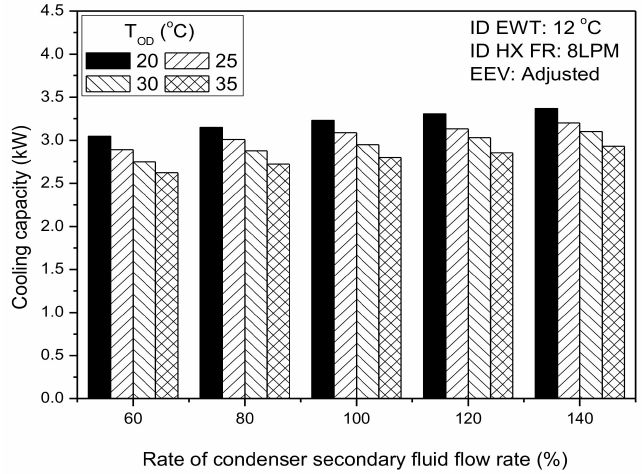
Figure 5. Variation of cooling capacity with condenser flow rate and T OD .